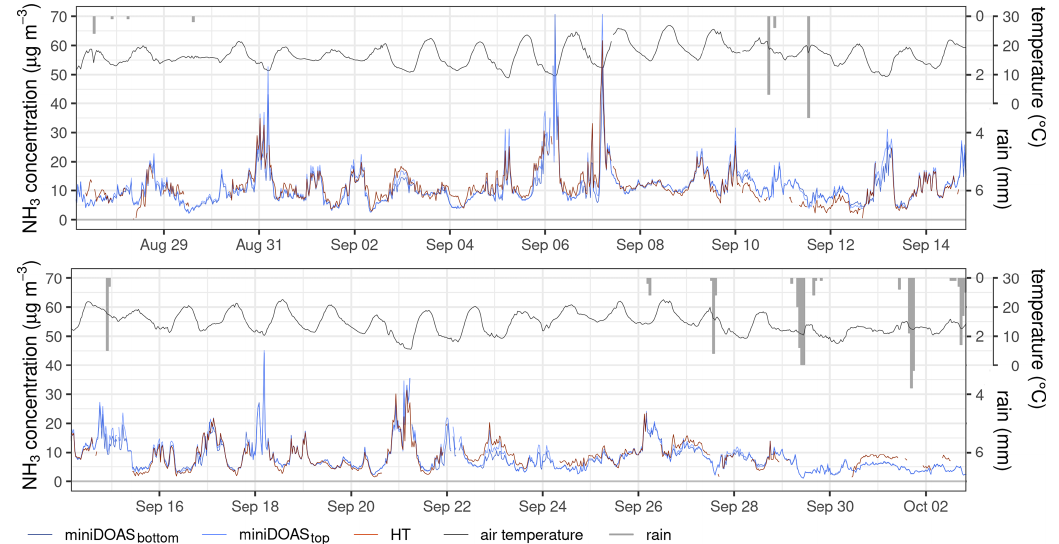
Figure 6. Time series of the measured unfiltered NH 3 concentrations after temperature correction from the HT (red) and the miniDOAS instruments (dark blue for miniDOAS bottom ; light blue for miniDOAS top in µgm − 3 , the hourly ambient temperature (black) in ◦ C and the amount of rainfall (grey bars) in